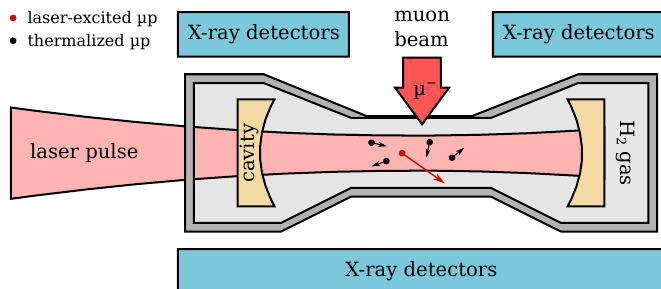
Figure 2: (Color online) Schematic (not to scale) of the setup for measuring the HFS in µ p. A negative muon beam is stopped in a H gas target at cryogenic temperatures, 2 pressures of about 1 bar, and a thickness of about 1 mm. The formed µ p atoms are excited by the laser pulse whose intensity is enhanced in the multi-pass cavity. A successful laser excitation of the µ p atoms followed by a collisional deexcitation leads to a µ p atom with extra kinetic energy. With this extra kinetic energy, the µ p atom diffuses to the target walls where x-rays are